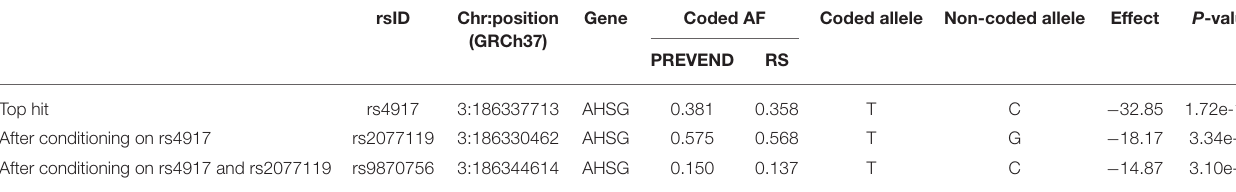
TABLE 2 | Details of three independent SNPs identified by T 50 GWAS.